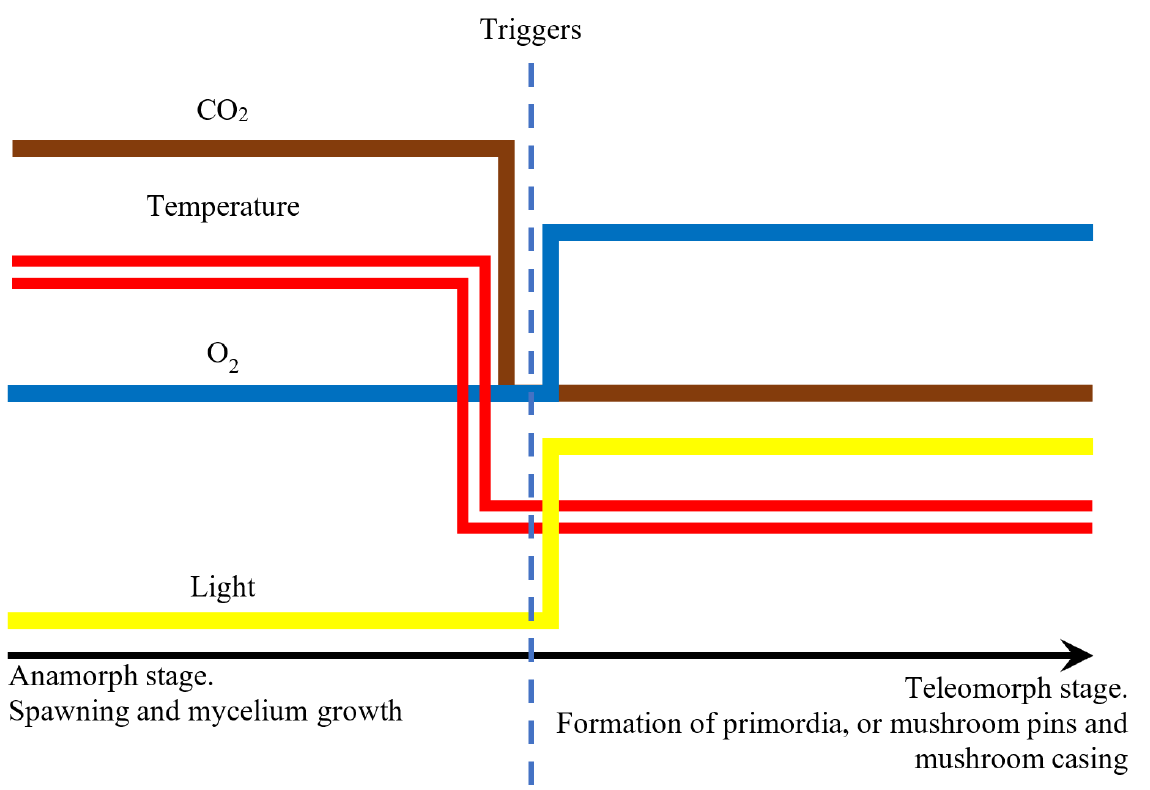
Figure 10. Triggers for the growth of fruiting bodies. ( 8) Mycelium deactivation in MBCs may consist in heat denaturation or otherwise.